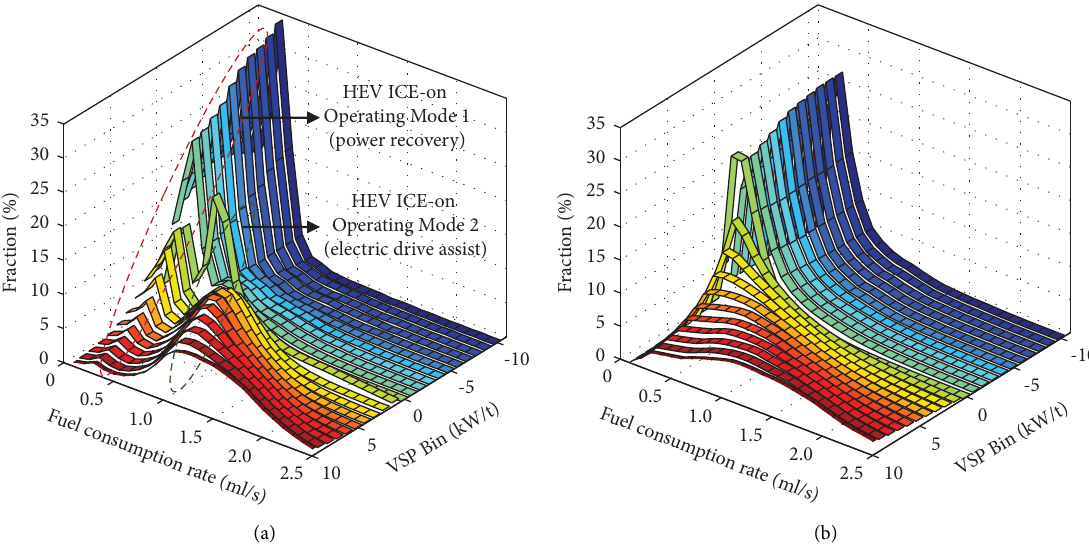
Figure 4: Instantaneous fuel consumption distribution of CVs and HEVs. (a) Te FCR of HEVs, (b) the FCR of